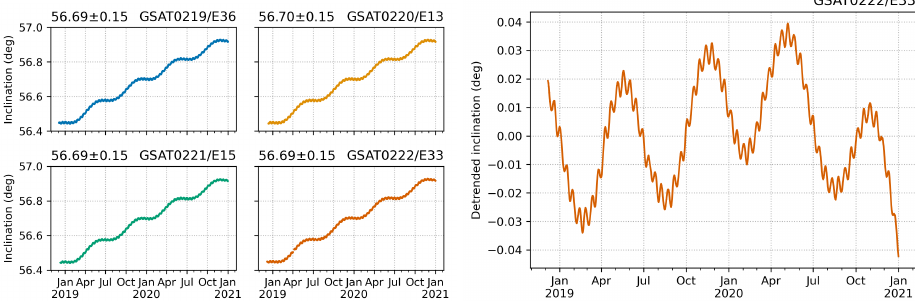
Figure 4. Orbit inclination evolution of the Galileo L10 satellites from the beginning of the nav- igation data transmission to December 2020: original values ( left ) and detrended values ( right ). [Unit: